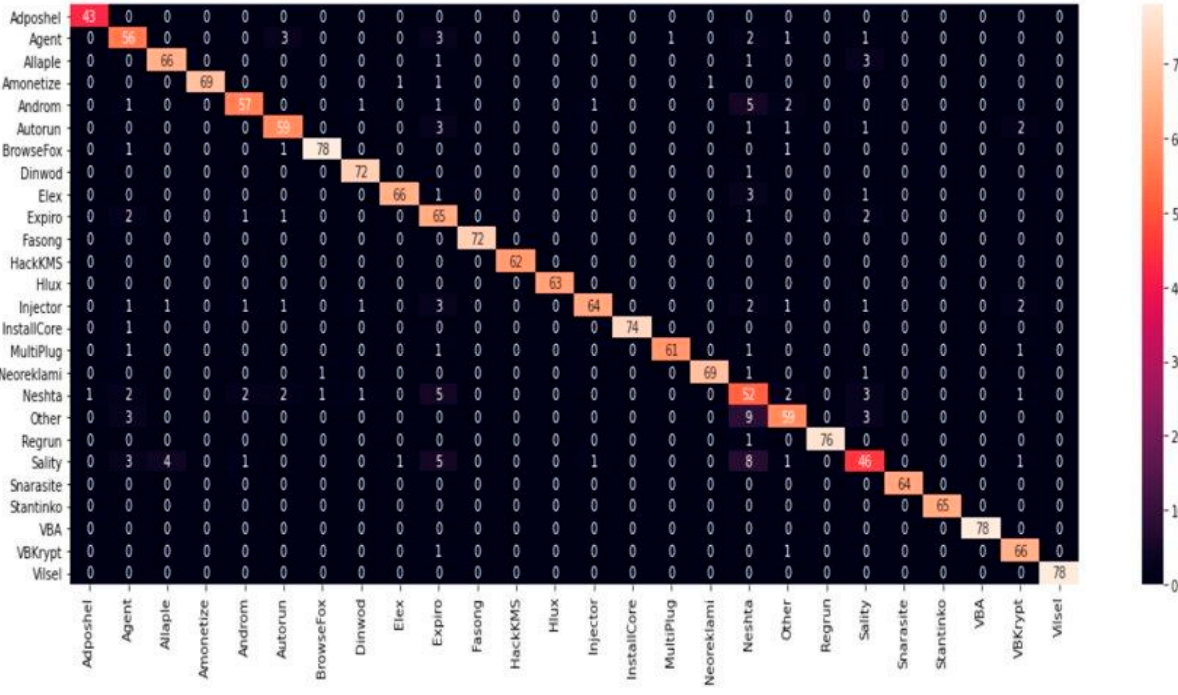
Figure 13. Confusion matrix for convolutional neural network.